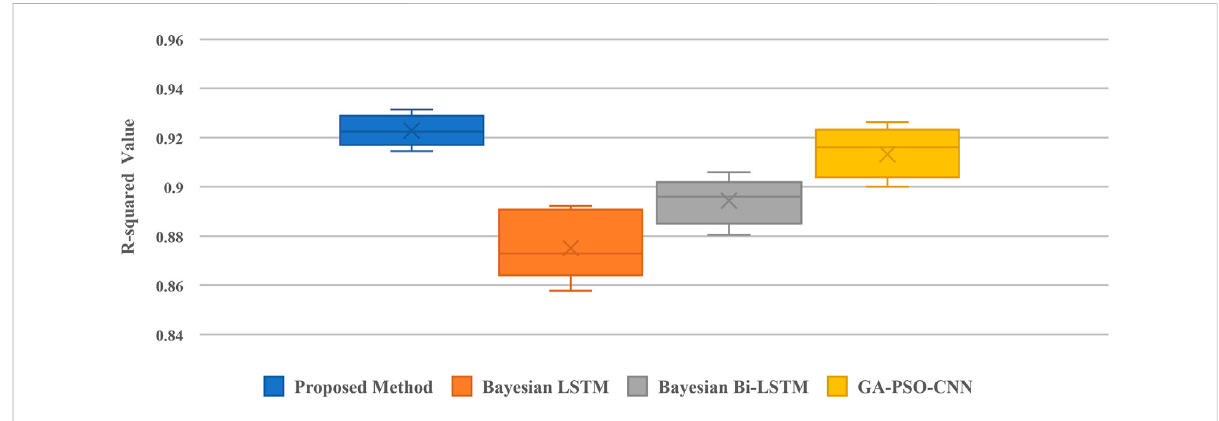
FIGURE 7 Boxplots of R-squared values of each forecasting methods with 100 sampling